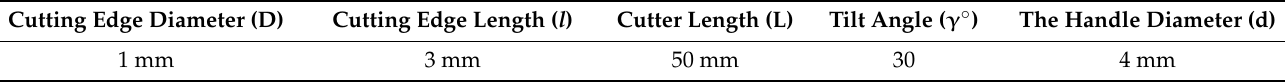
Figure 2. Micro-milling cutter and schematic diagram. Table 2. Tool geometry data. Cutting Edge Diameter (D) Cutting Edge Length ( l ) Cutter Length (L) Tilt Angle (γ°)